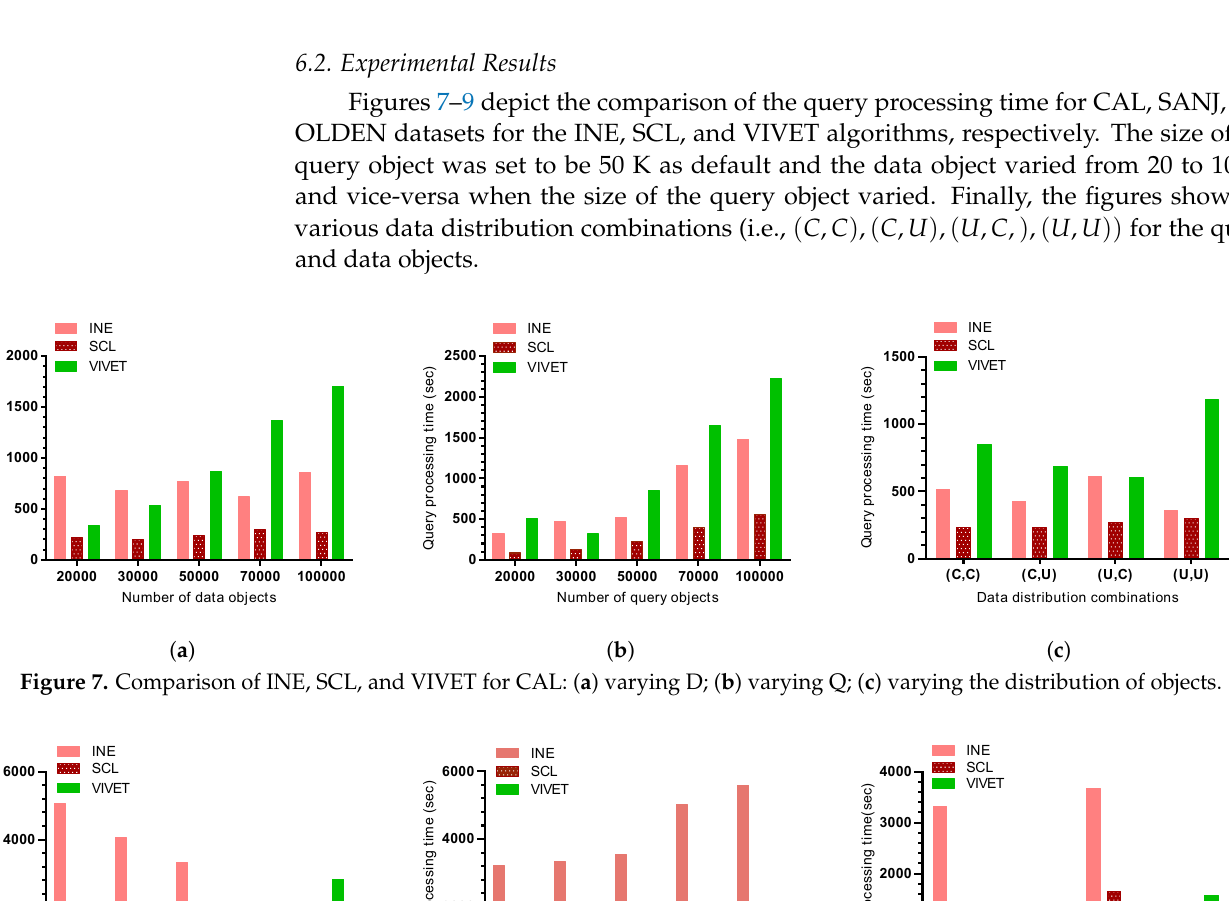
Number of data objects